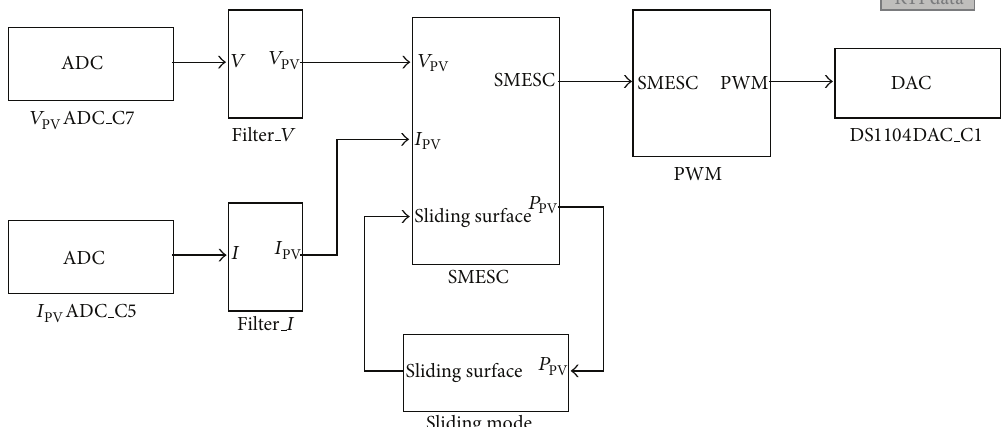
Figure 15: SMESC processing block.